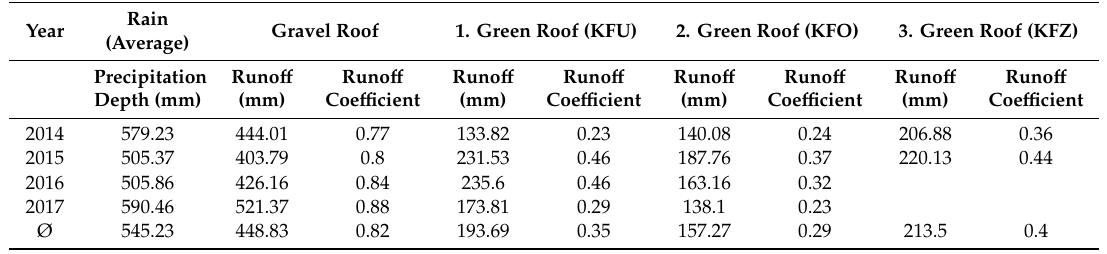
Table 3. Runo ff coe ffi cient of the EGRs and the gravel roof. The measurements for No. 3 (KFZ) were not available for 2016 and 2017.